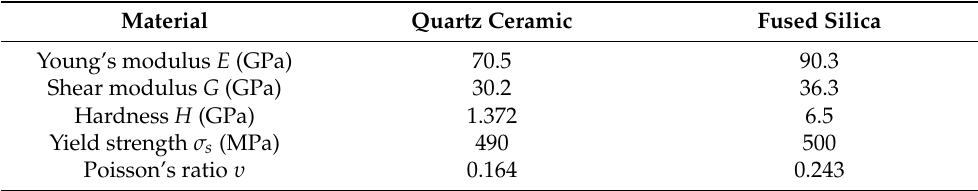
Table 2. Reticle and chuck material parameters.